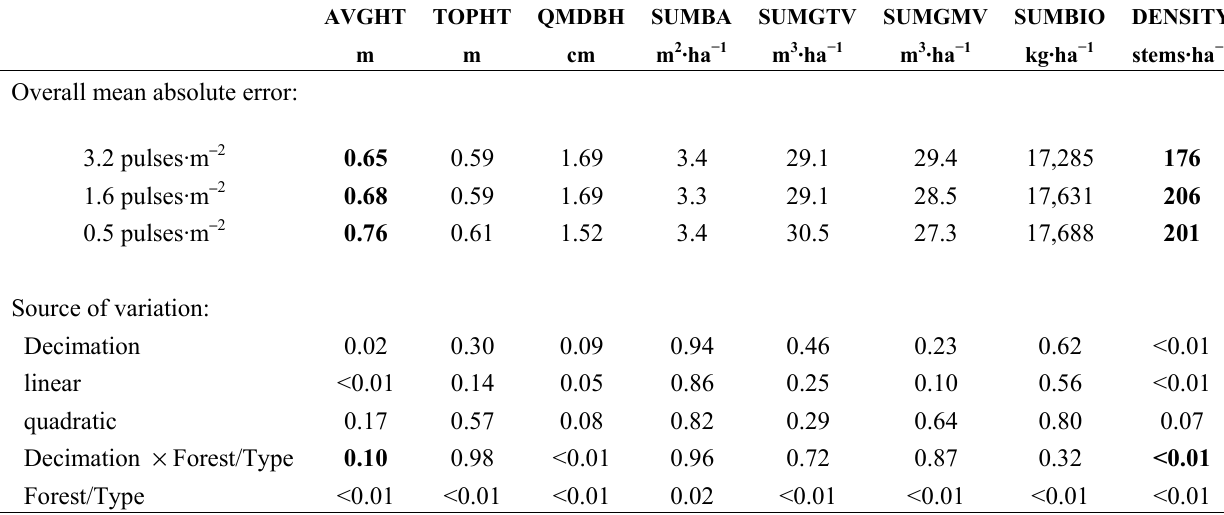
Table 6. Summary of mean absolute errors for the decimation levels tested and p -values from RMANOVA (Wilks’ lambda) testing for decimation and forest/type effects and their interaction. (Note: values in bold suggest a loss of precision with increasing decimation for some